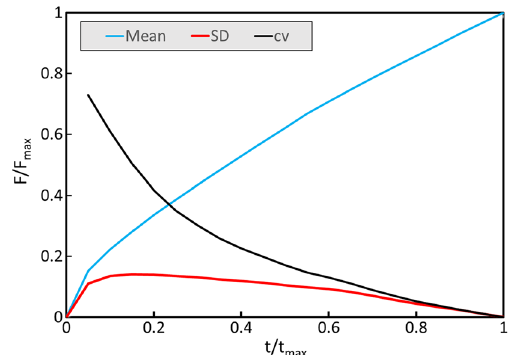
Fig. 8 Variation of statistical parameters of the dimensionless cumu- lative infiltration ( F / F max ) versus the dimensionless time ( t / t max ): mean, standard deviation (SD), and coefficient of variation (cv)